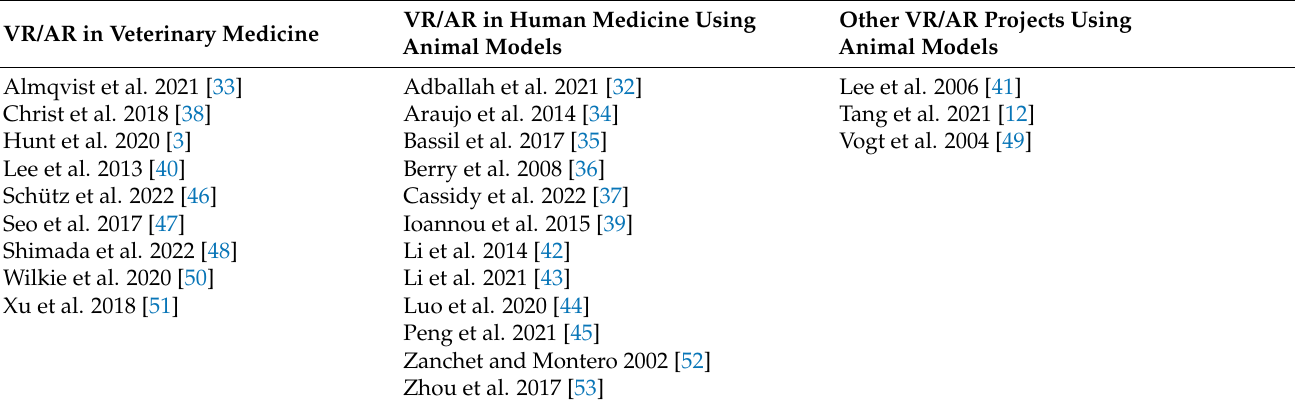
Table 2. Classification of included articles based on